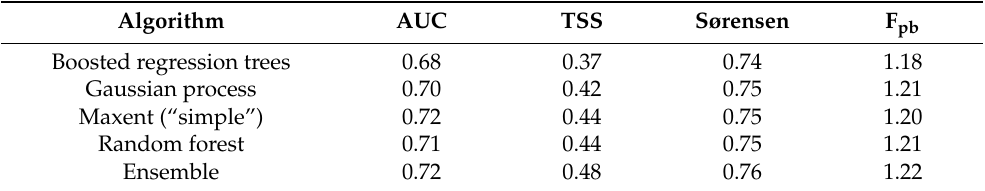
Table 3. Evaluation metrics for individual correlative models and the ensemble correlative model for Calonectria pseudonaviculata . Algorithm AUC TSS Sørensen F pb Boosted regression trees